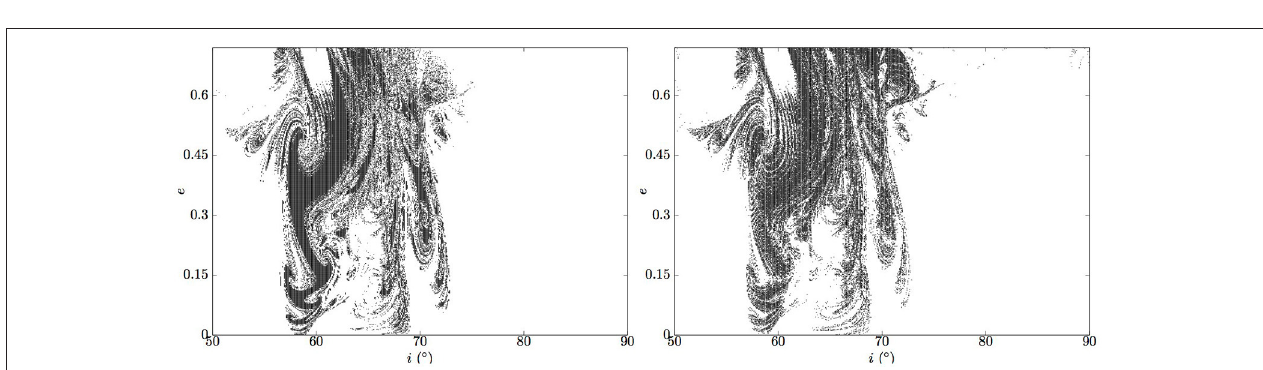
0.35 (left hand-side) and the chaotic ICs satisfying FLI( x , τ run ) ≥